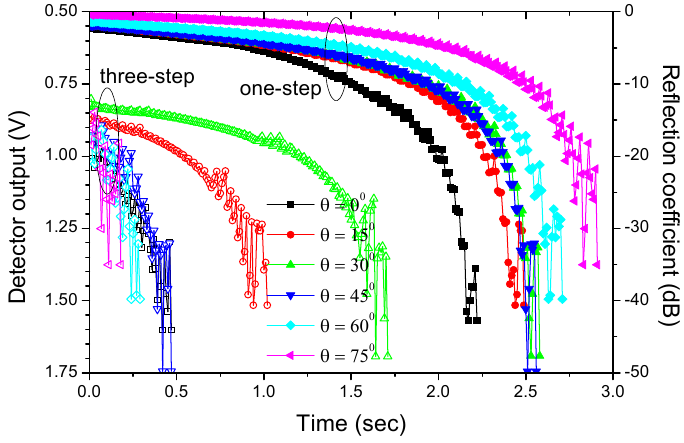
Figure 18. Measured detector output and reflection coefficient versus time for different angular misalignments, d = 40 cm.